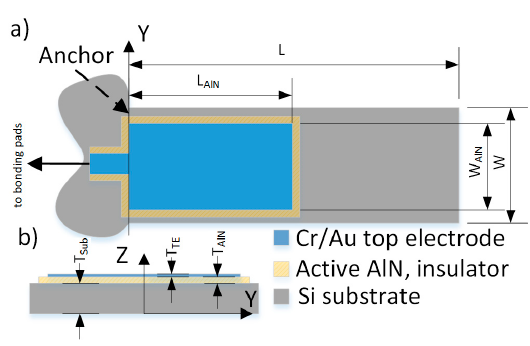
Figure 1. Schematics of the piezoelectric MEMS cantilever. In ( a ) the top and in ( b ) the cross-sectional view are shown.